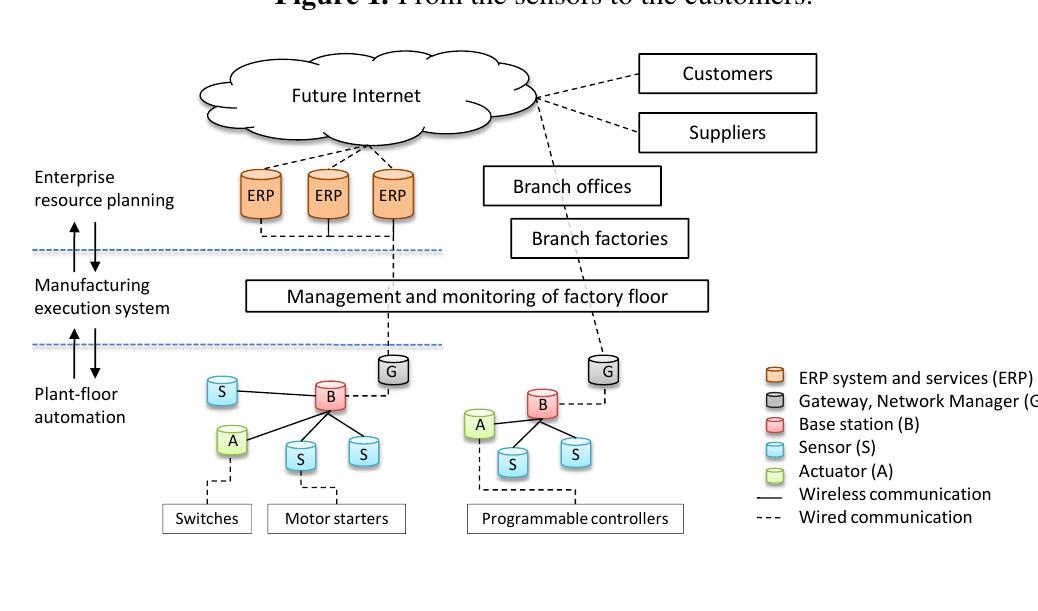
Figure 1. From the sensors to the